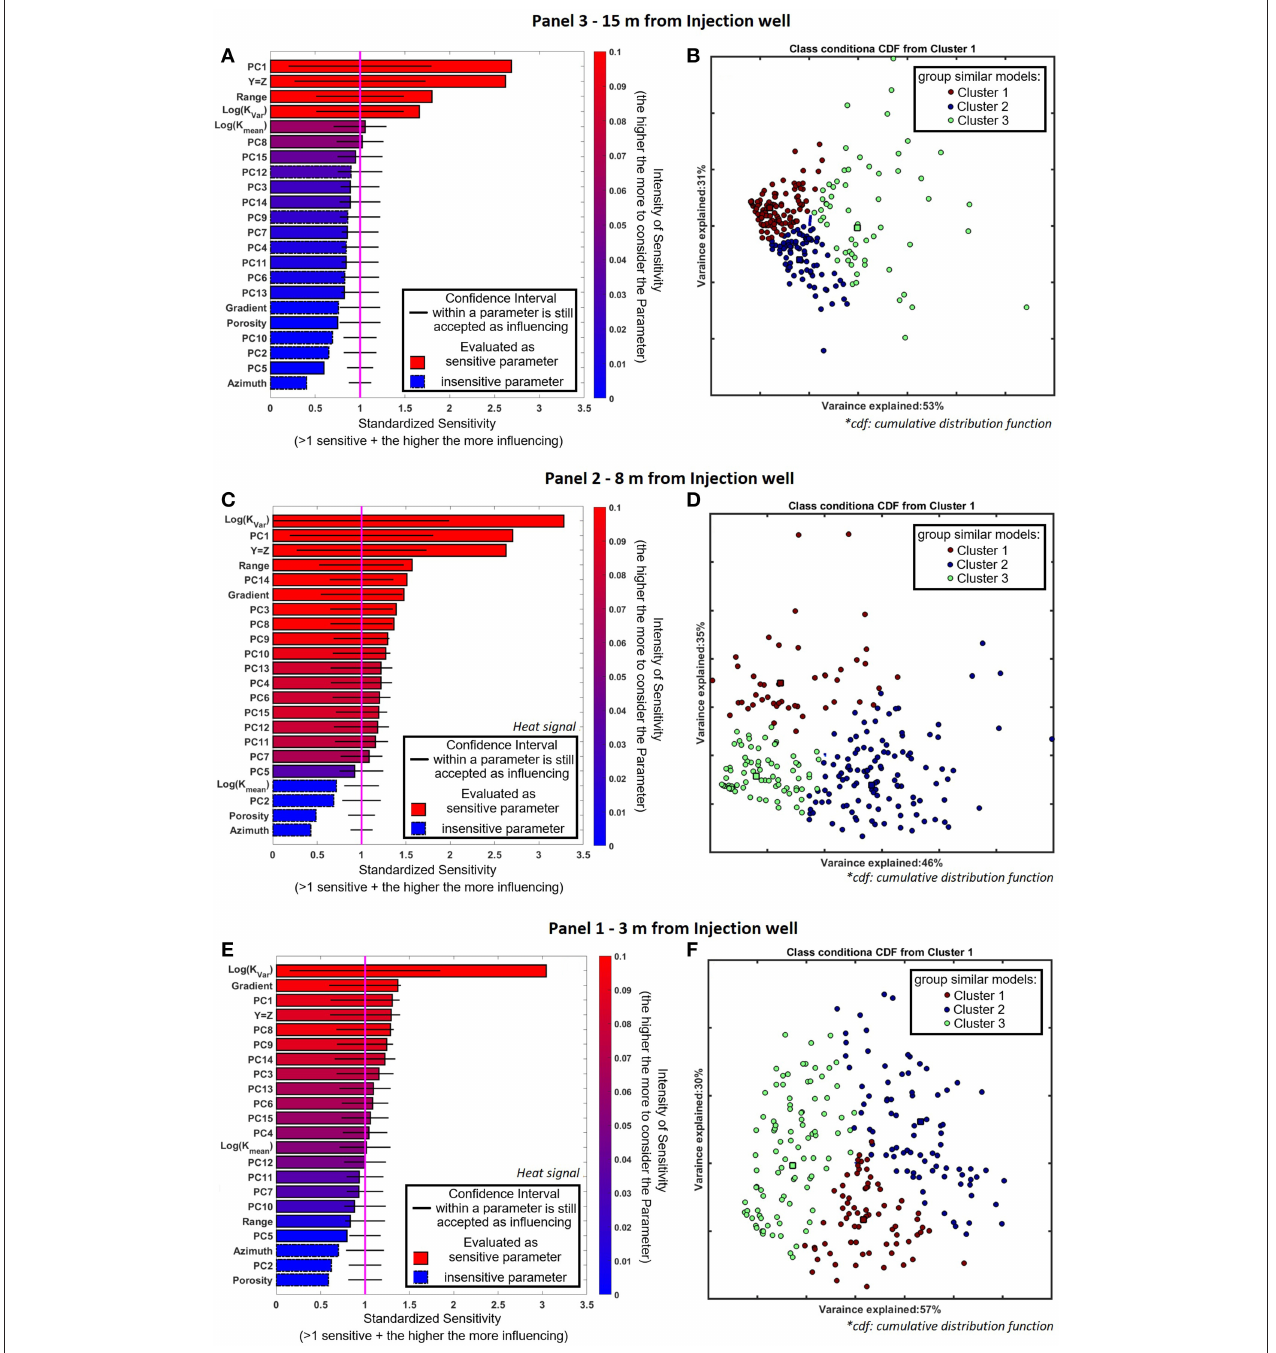
FIGURE 6 | Distance-based sensitivity analysis using the scenario B heat signals at (A) Panel 3, (C) Panel 2, (E) Panel 1, related to the corresponding cluster cumulative distribution function (CDF) for (B) Panel 3, (D) Panel 2, and (F) Panel 1. The square within each cluster in (B), (D), and (F) is the center of mass of each